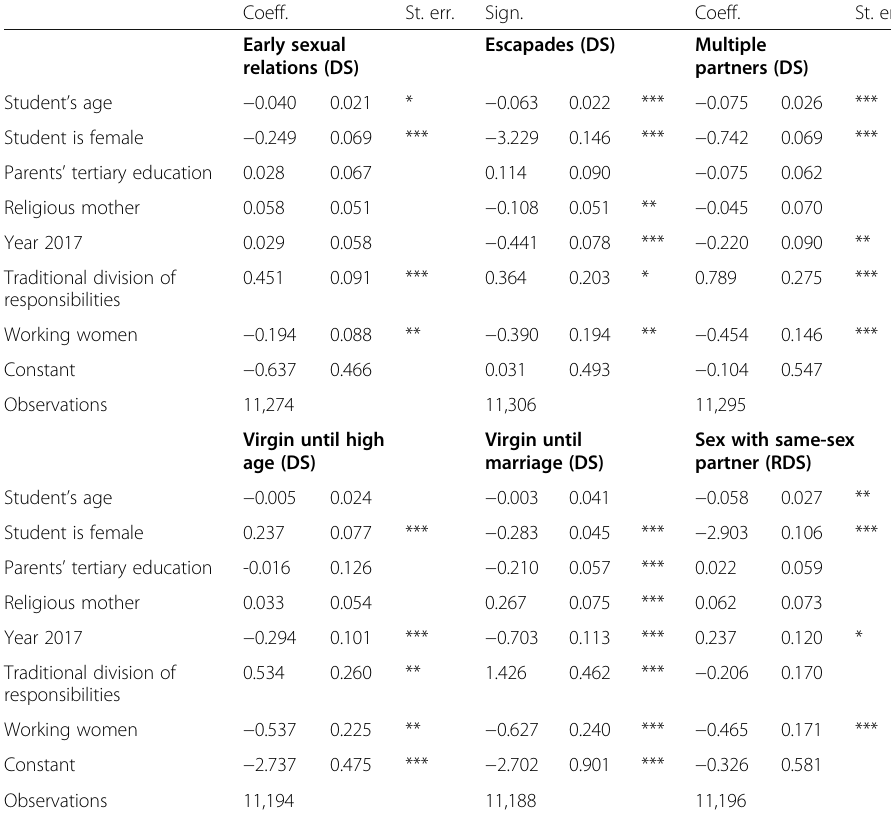
Table 4 The determinants of DS/RDS Coeff. St. err. Sign.